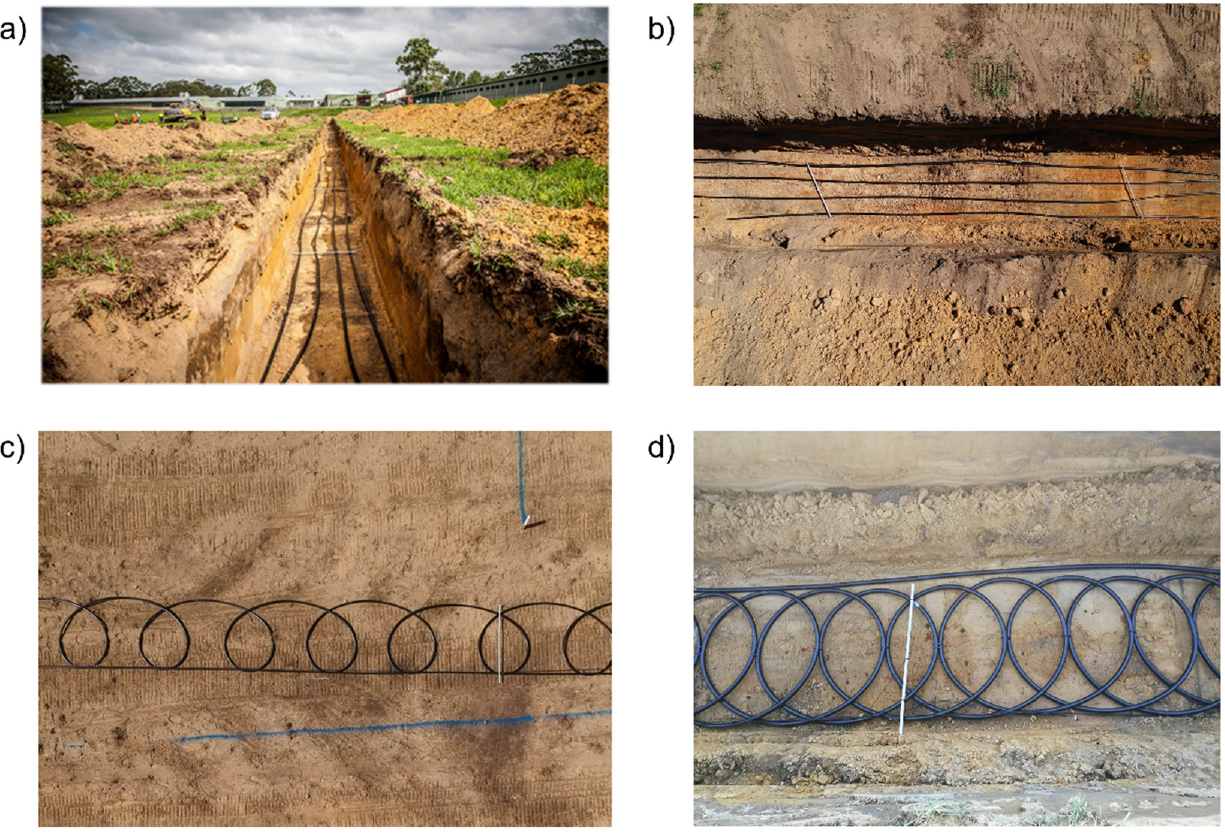
Figure 3. Ground heat exchangers in the field: ( a ) horizontal straight loop in a trench; ( b ) horizontal straight loop; ( c ) slinky loop; ( d ) dense slinky loop.